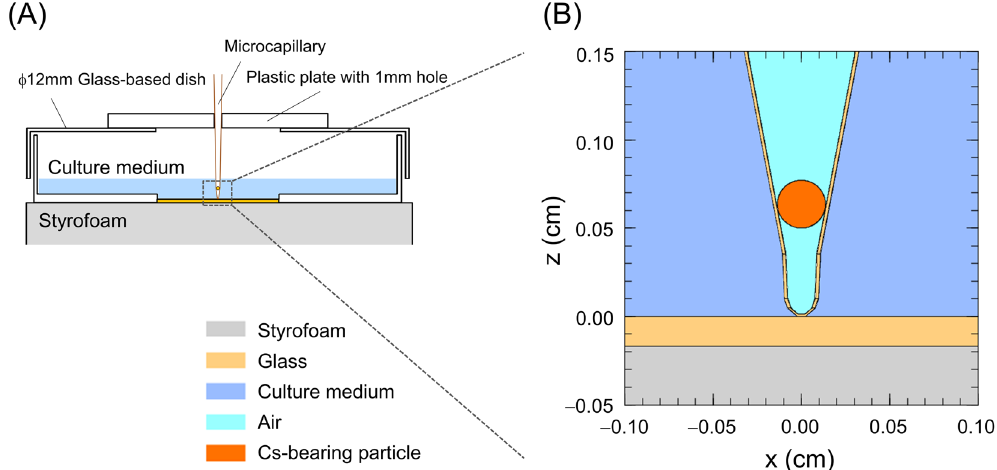
Figure 1. Geometry for positioning of a Cs-bearing particle. ( A ) How to place the microcapillary containing the Type B particle with 505.7 Bq, ( B ) Microenvironment described by the PHITS code. The tip of the capillary was closed, the inside of which was filled with air. The diameter and position of the Cs-bearing microparticle were measured by using the Image J software.